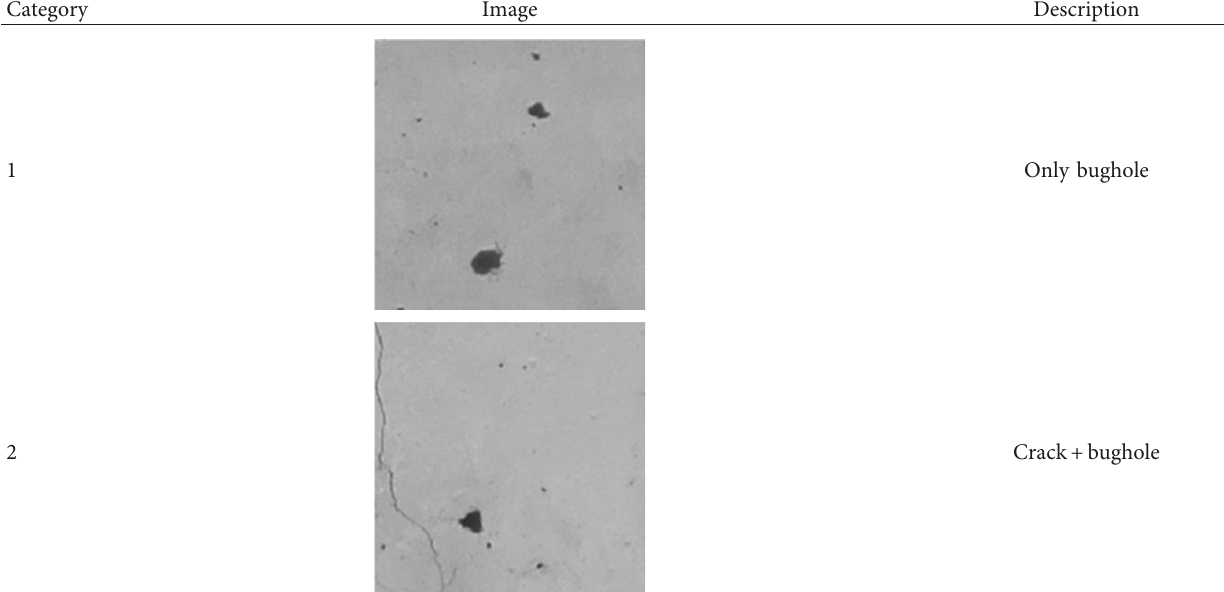
Table 1: Image categories of concrete surface